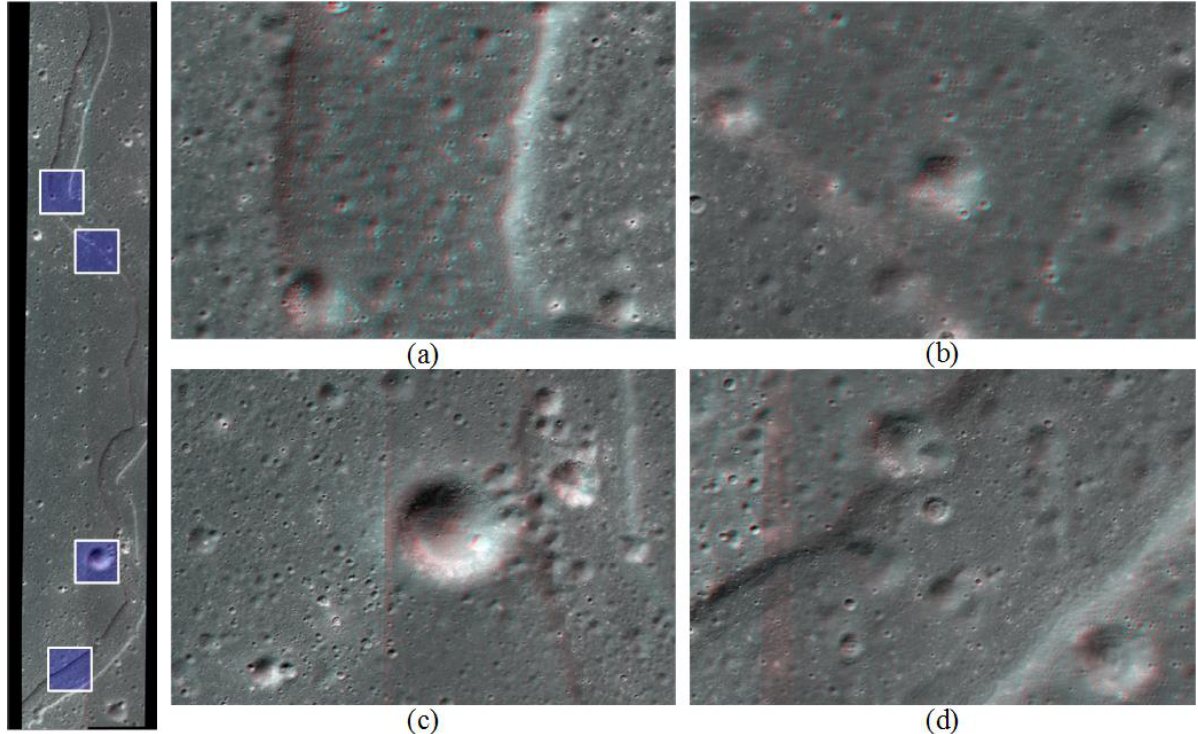
Figure 5. Anaglyphs of the whole epipolar images and selected regions. The enlarged views through a to d indicated the blue shaded box in the left thumbnails from top to bottom. The color bias in the middle of the anaglyphs is caused by the color inconsistency between the NAC-L and NAC-R. The color mode of the anaglyphs are red/left to cyan/right, please wear corresponding filter glasses for stereo effects.